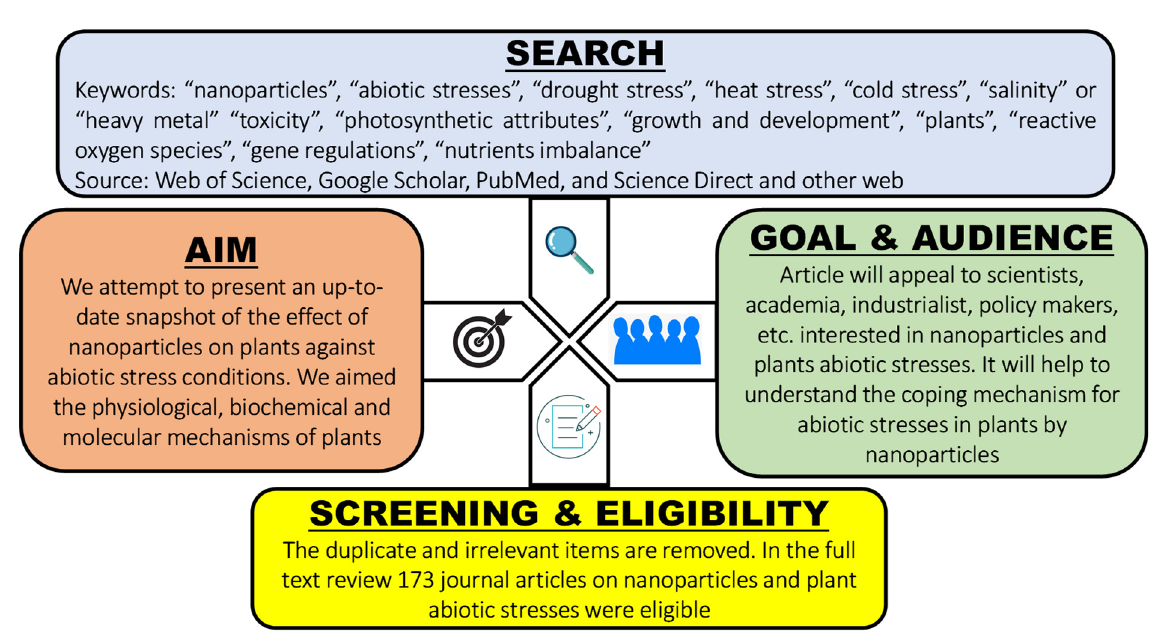
Figure 2. Schematic diagram depicting the decision-making process for the selection of a journal article, and the scope of the review.